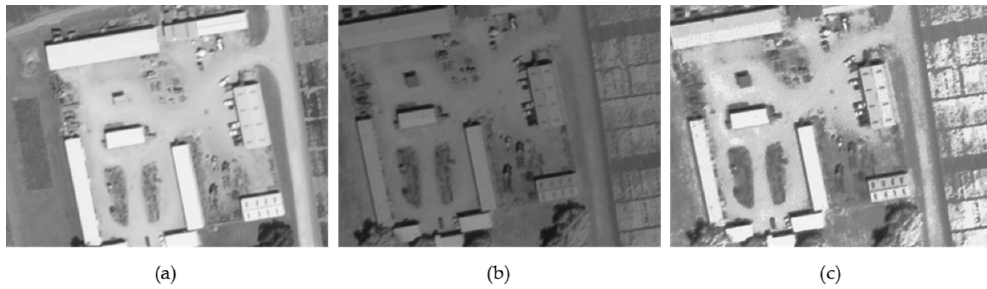
Figure 7. Images before and after specification: ( a ) RGB grayscale image; ( b ) initial NIR grayscale image; and ( c ) NIR grayscale image specified to RGB grayscale image.